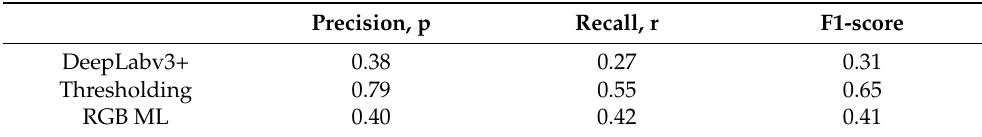
Table 1. Precision, p , recall, r , and F1-score for results from the DeepLabv3+, thresholding and false RGB ML analysis. Precision, p Recall, r F1-score DeepLabv3+ Thresholding 0.79 RGB ML 0.40